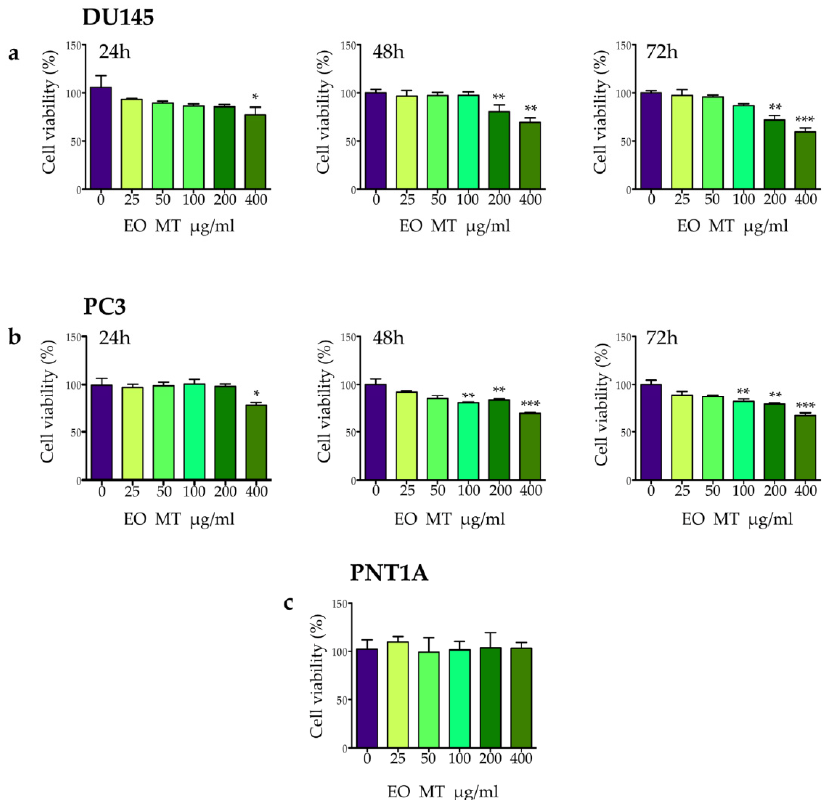
Figure 2. ( a – c ). Effect of the leaf essential oil of Myrtus communis subsp. tarentina (L.) Nyman (EO MT) on DU145 ( a ), PC3 ( b ), and PNT1A ( c ) cell viability. DU145 and PC3 cells were exposed to